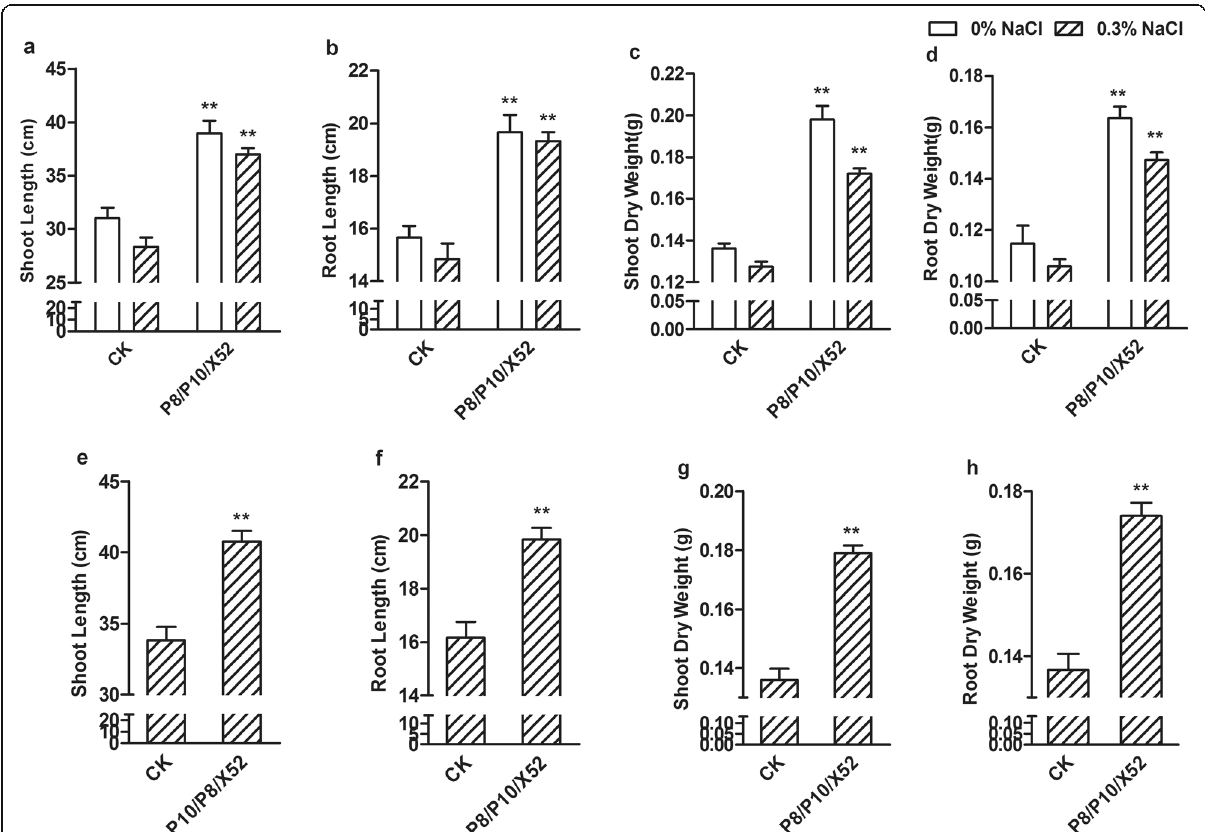
Fig. 1 The effects of P8/P10/X52 consortium on maize growth in substrates supplied with 0.3% NaCl. In sand: a the shoot length of maize; b the root length of maize; c the shoot dry weight; d the root dry weight of maize. In soil: e the shoot length of maize; f the root length of maize; g the shoot dry weight; h the root dry weight of maize. CK, control. ** indicates the significant difference ( p < 0.01) for treatments inoculated with P10/P8/X52 consortium compared with control